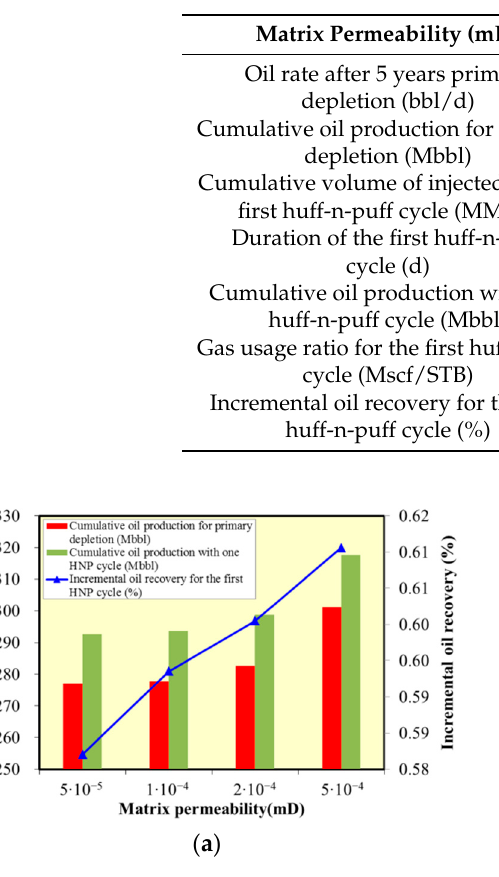
Figure 11. Correlation between matrix permeability and huff-n-puff results: ( a ) Cumulative oil production and incremental oil recovery for different matrix permeability; ( b ) Duration of the first huff-n-puff cycle and gas usage ratio for different matrix permeability.